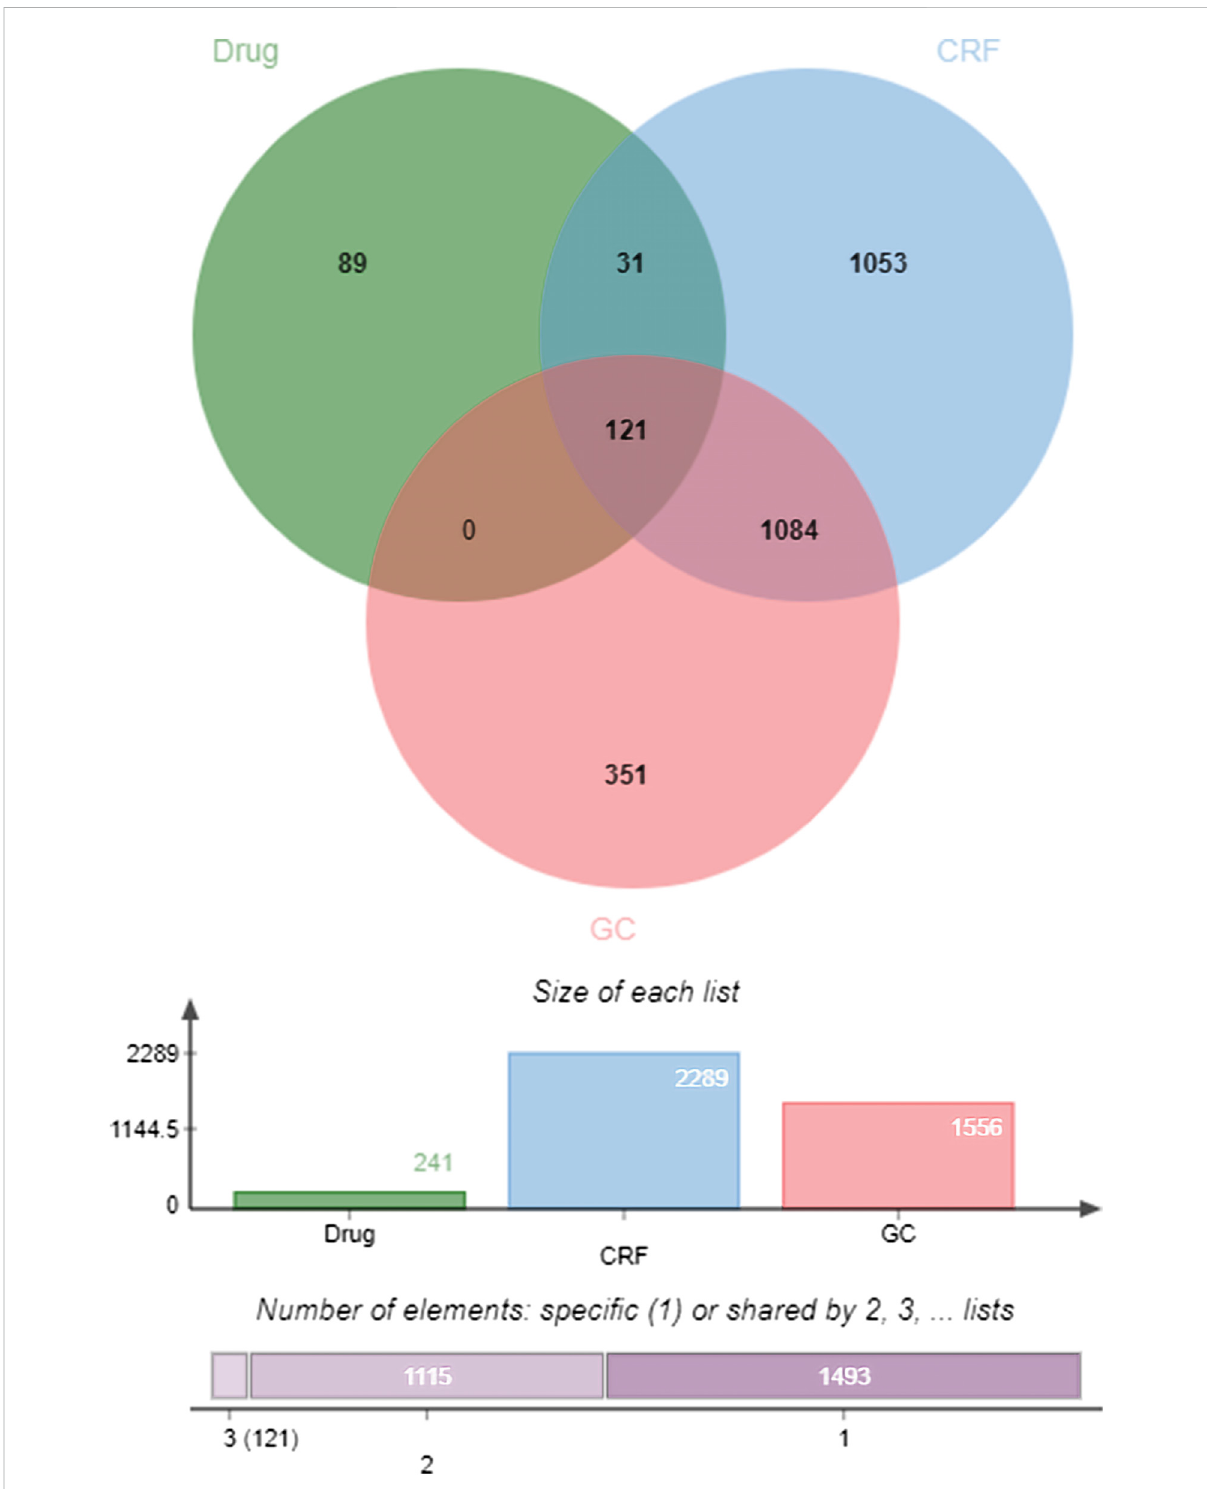
FIGURE 13 Venn diagram of “ Drug — GC — CRF ” targets (Drug refers to botanical drug, GC is gastric cancer, and CRF means cancer-related